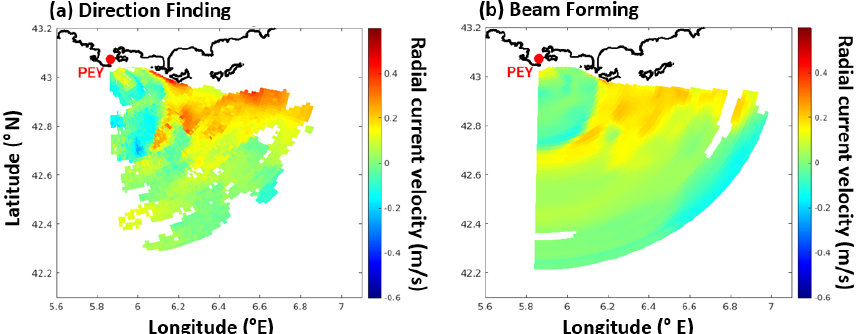
Figure 3. Hourly radial surface current maps obtained on 1 September 2020 at 06:00TU with the HFR station deployed in Fort Peyras (PEY) in Toulon (SE France) with a 12-antenna receiving array operating at 16.15MHz. The range resolution is 1.5km and the maximum range is about 80km. (a) Radial map obtained by using antenna grouping and self-calibration: fine and contrasted structures are unveiled. (b) Radial map obtained using the classical beam forming azimuthal processing: small patterns are smoothed and contrast is